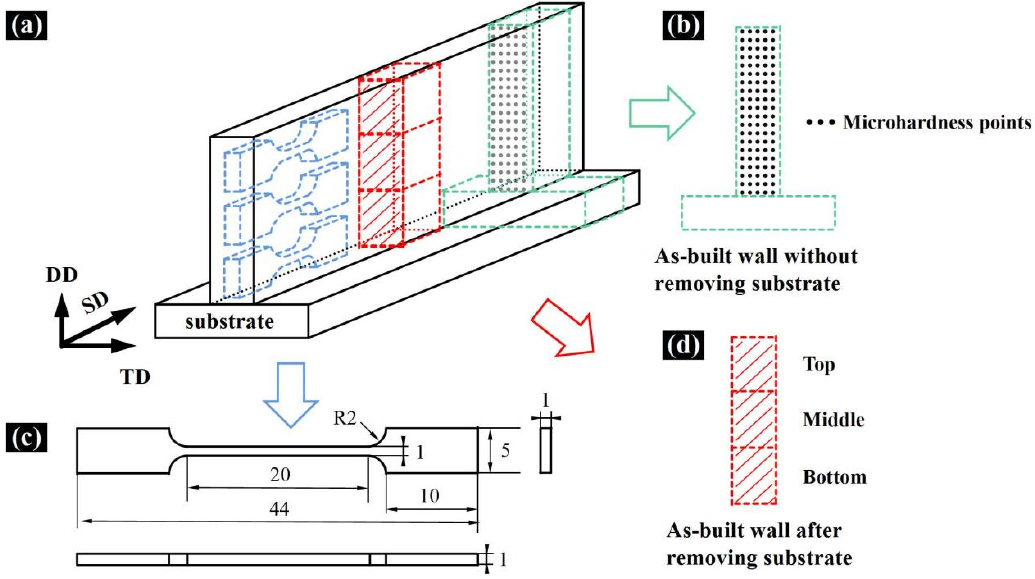
Figure 3. Schematic diagram of sample location and size: ( a ) sampling location; ( b ) microhardness sample; ( c ) tensile sample (in mm); ( d ) OM and XRD samples.